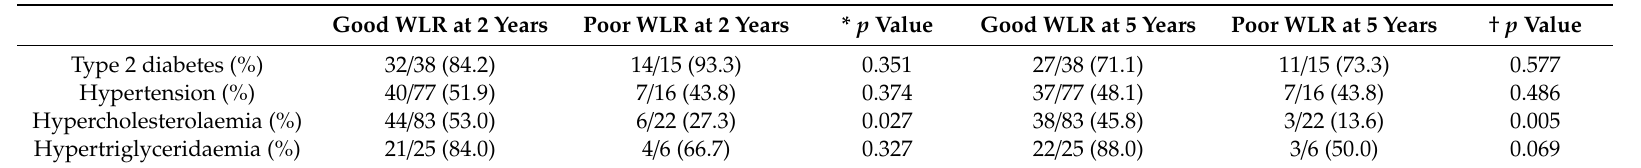
Table 3. Remission rate of metabolic comorbidities in good and poor weight loss responders at 2 and 5 years post-surgery.